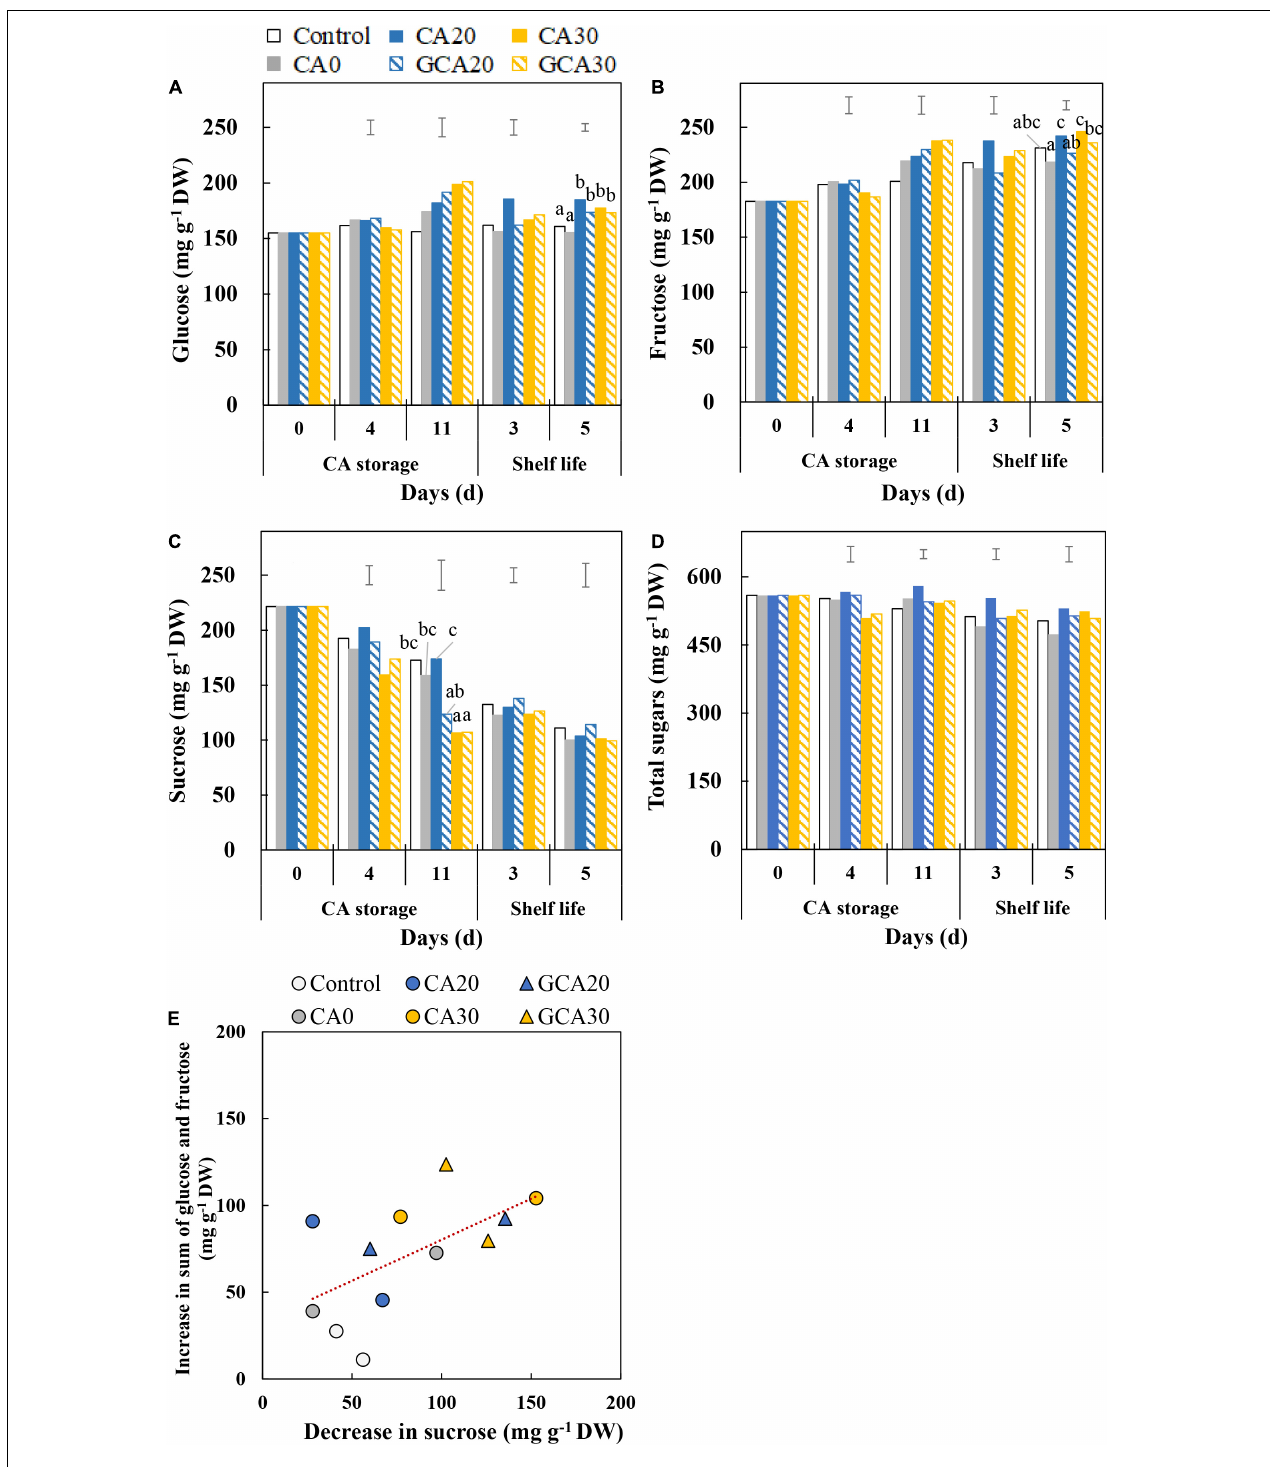
FIGURE 3 | Soluble sugars of “Arabella” strawberry fruit during CA storage and shelf life. (A) Glucose, (B) fructose, (C) sucrose, and (D) total sugar (sum of glucose, fructose, and sucrose) during CA storage at 5 ◦ C and ∼ 100% relative humidity and subsequent shelf life at 12 ◦ C and ∼ 95% relative humidity in ambient atmosphere. Data represent means of 2 blocks ( n = 2; each block being a pooled sample of 20 replicated fruit). Different letters denote significant differences according to Fisher’s protected LSD test ( α = 0.05). The error bars represent the standard error of means. (E) Correlation between the increased content of glucose and fructose and the decreased content of sucrose between day 0 and day 11 during CA storage. Data represent individual blocks. As a control condition, 21 kPa O 2 and 0 kPa CO 2 were used.